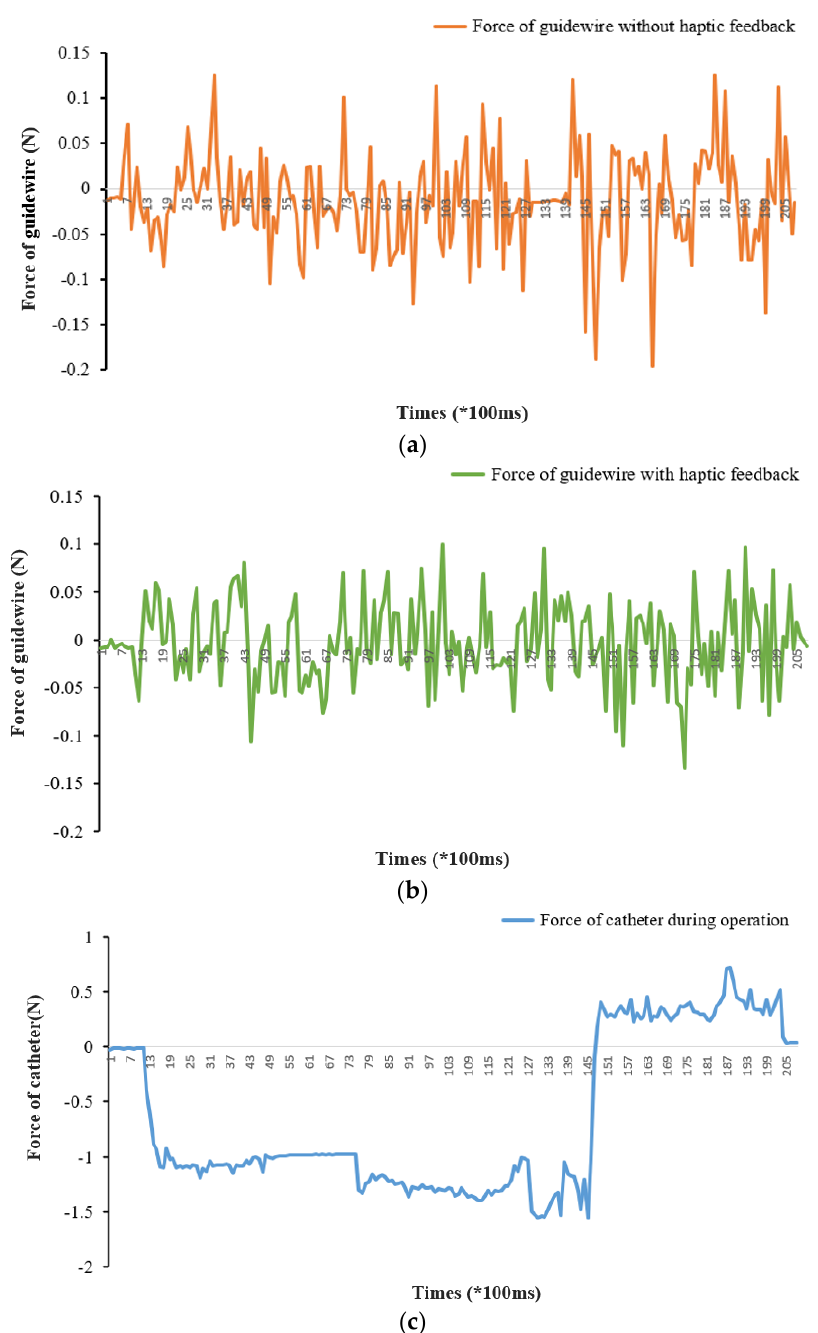
Figure 16. Experimental results for in vitro experiments: ( a ) the measured force of the guidewire without haptic feedback; ( b ) the measured force of the guidewire with haptic feedback; ( c ) the measured force of the catheter during the operation.